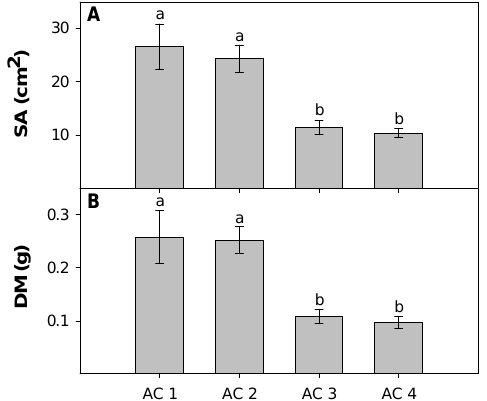
Figure 4. Leaf surface area (SA) ( A ) and leaf dry mass (DM) ( B ) in relation to ash tree canopy condition